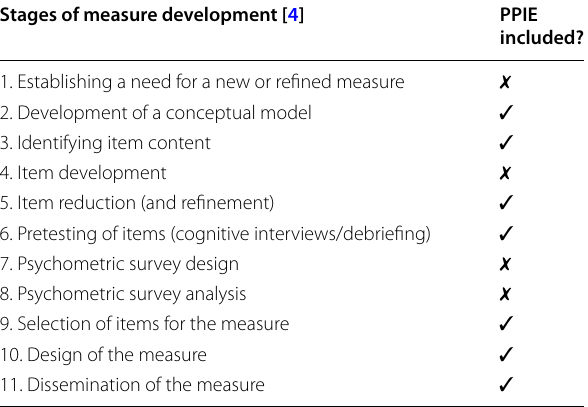
Table 3 PPIE engagement for each stage of development within Extending the QALY project Stages of measure development [4] PPIE